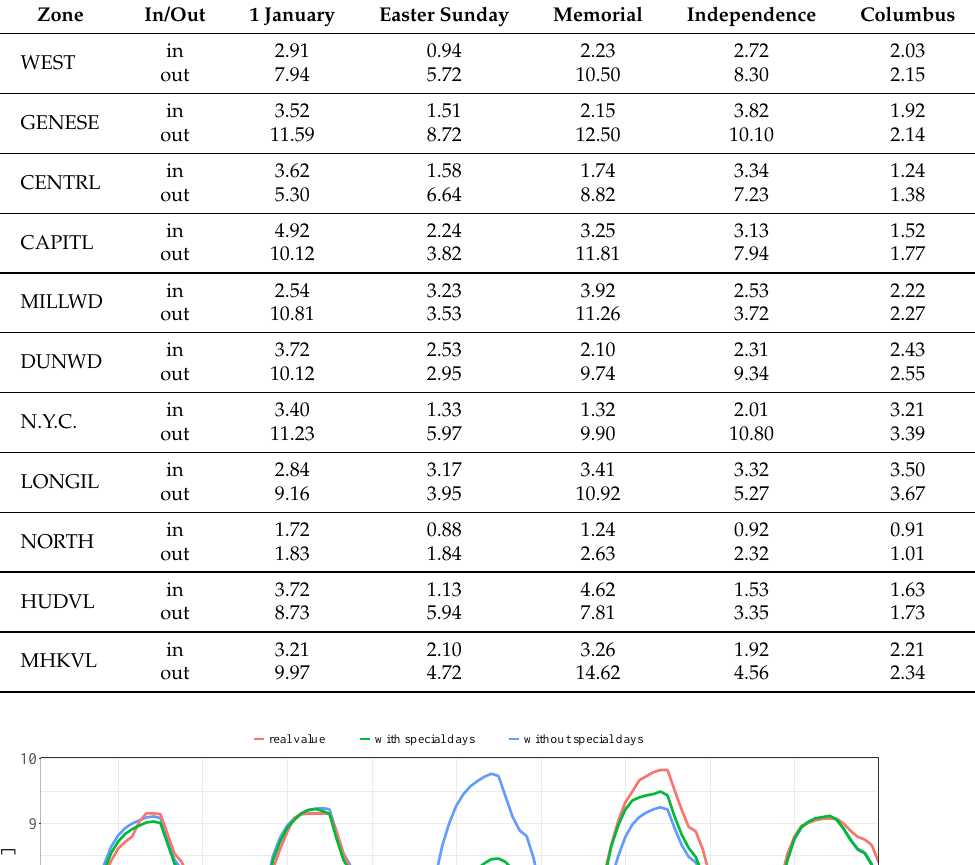
Table 5. MAPE results for special days for each NYISO zone.